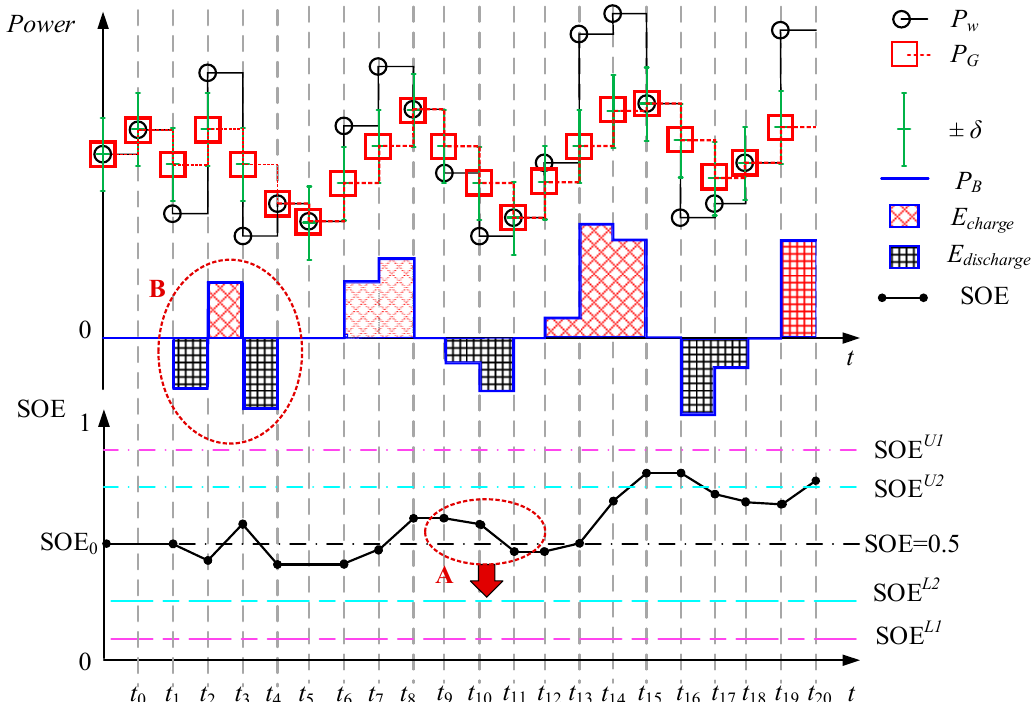
Figure 2. Schematic diagram of wind power fluctuation smoothing by energy storage battery. SOE : state-of-energy; SOE U and SOE L : SOE upper and lower limits of energy storage system, δ : Tange of active wind power fluctuations permitted to be connected to the grid;. E charge and E discharge : Battery charging and discharging energy.